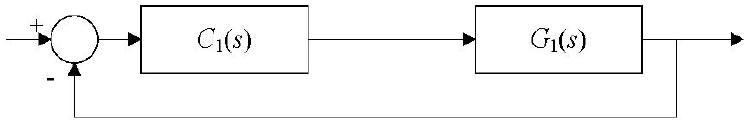
Figure 2. Block-diagram of the drive train control in wind turbine